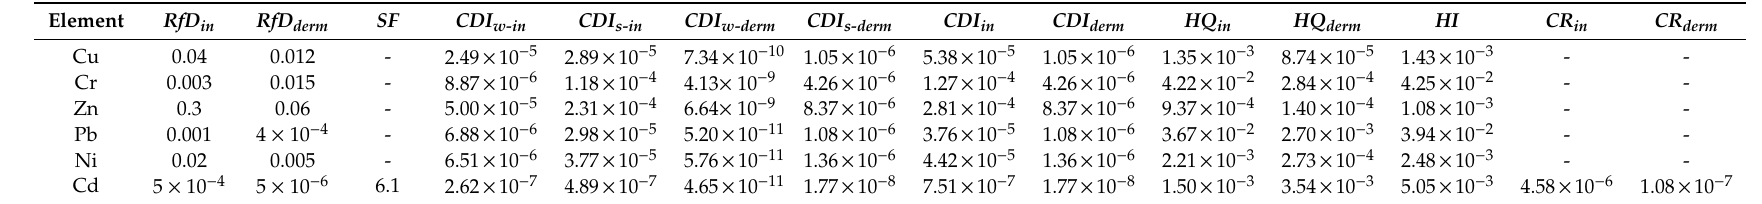
Table 3. Hazard quotient and carcinogenic risk for each element and exposure